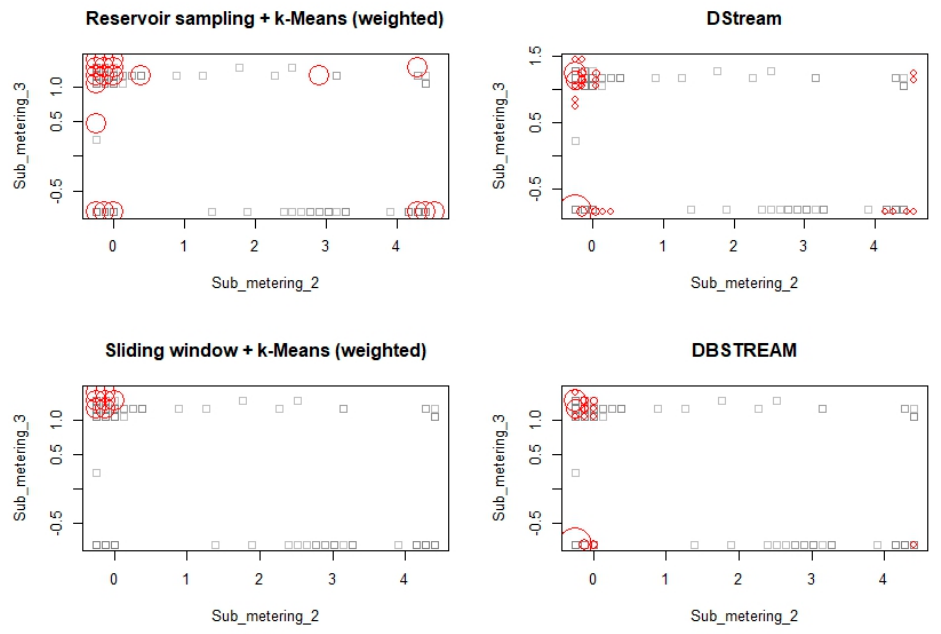
Figure 7. Micro-cluster placement for different algorithms. Reading of sub_meter_1 and sub_meter_2 are selected for formation of clusters (using real data stream).